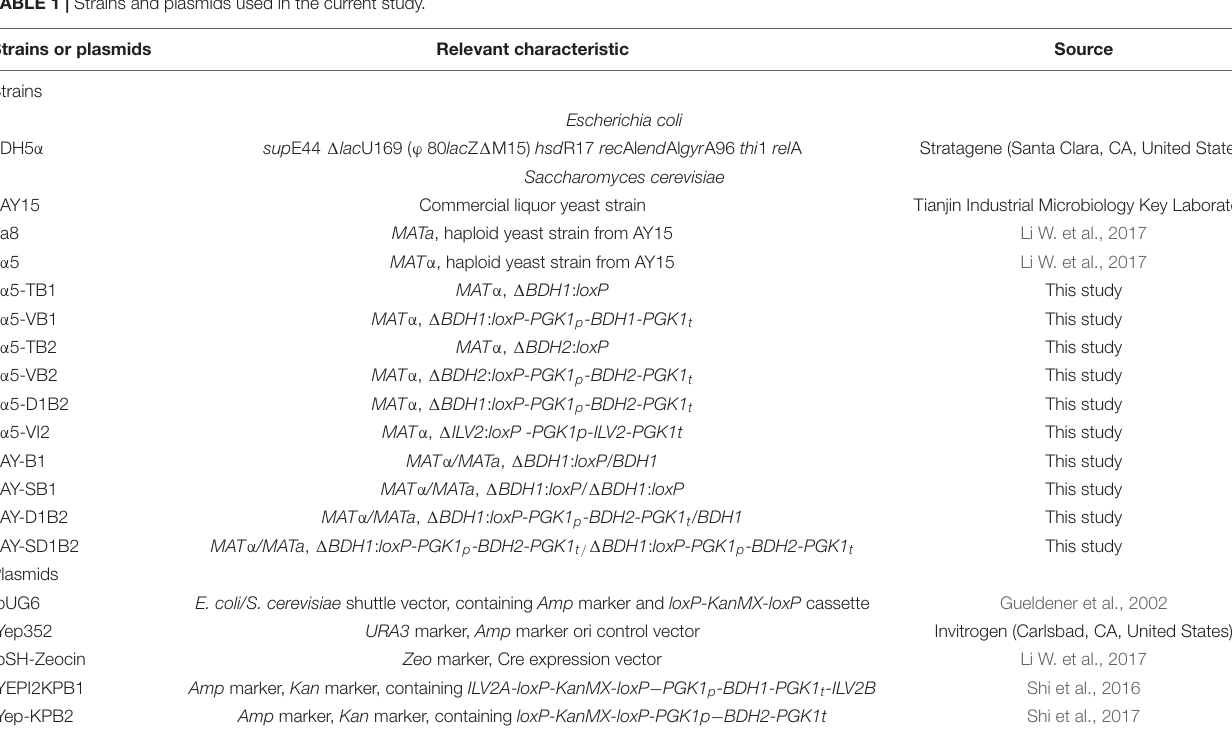
FIGURE 1 | TTMP and acetoin pathway construction in Saccharomyces cerevisiae. The green arrows indicate the enhanced pathways. The red cross mark indicates the disrupted pathways. ALS, α -acetolactate synthase, encoded by ILV2 ; PDC, pyruvate decarboxylase, encoded by PDC1 , PDC5 , and PDC6 ; ALD, acetaldehyde dehydrogenase, encoded by ALD6 ; ADH, alcohol dehydrogenase, encoded by ADH1 , ADH3 , and ADH5 ; BDH, 2,3-butanediol dehydrogenase, encoded by BDH1. TABLE 1 | Strains and plasmids used in the current